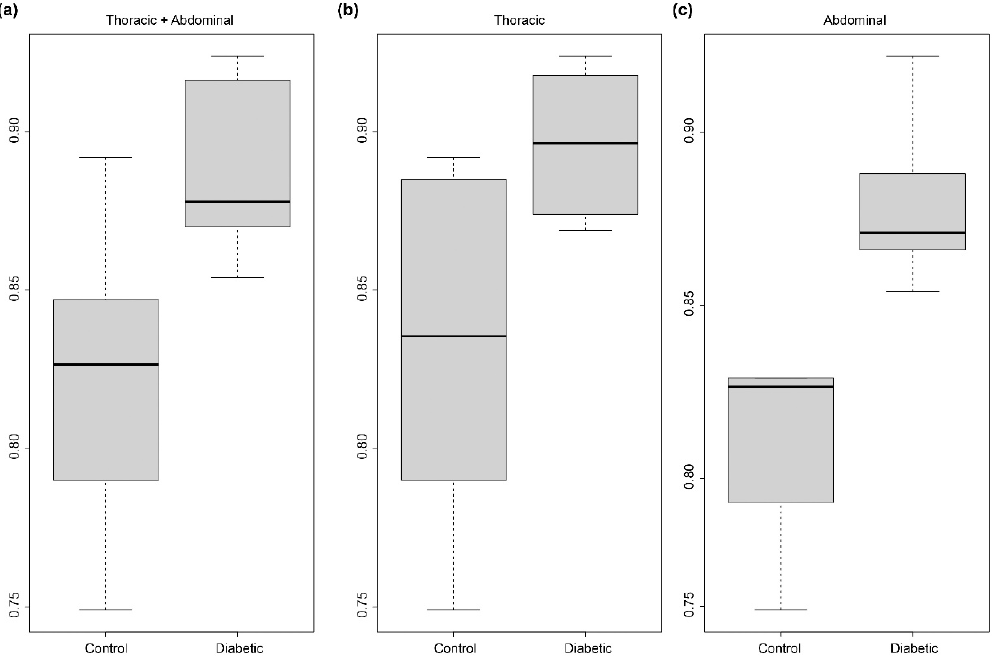
Figure 4. Box charts of ratio r ec obtained for control (C57Bl6J) and diabetic (db/db) 6-month mice. ( a ) All regions together ( p -value < 0.004), ( b ) only the thoracic region ( p -value < 0.065), and ( c ) only the abdominal region ( p -value < 0.02).